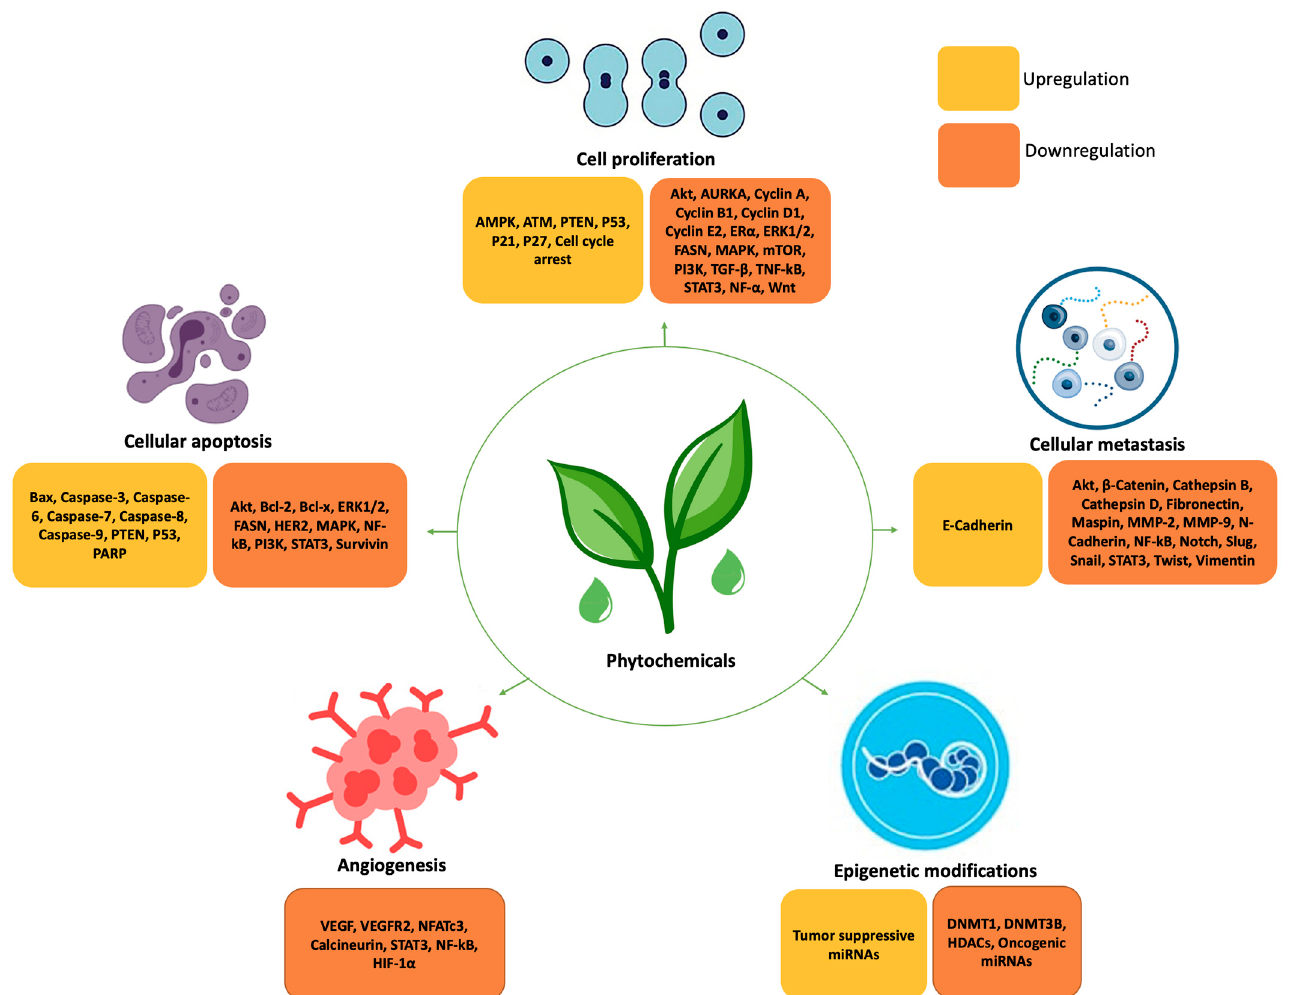
Figure 3. Classification of phytochemicals.